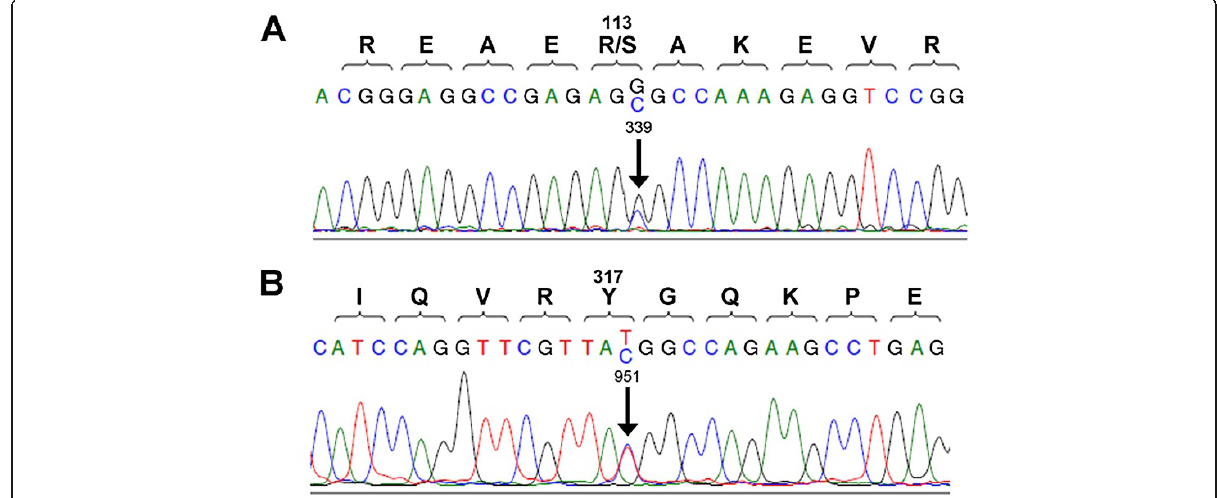
Figure 1 Sequence traces of novel Cx40 SNPs. ( A ) Sequence of 339G>C, a novel nonsynonymous Cx40 SNP identified in a lone AF atrial tissue sample. 339G>C results in the cytoplasmic loop substitution R113S. ( B ) Sequence of 951T>C, a novel synonymous Cx40 SNP identified in a lone AF blood